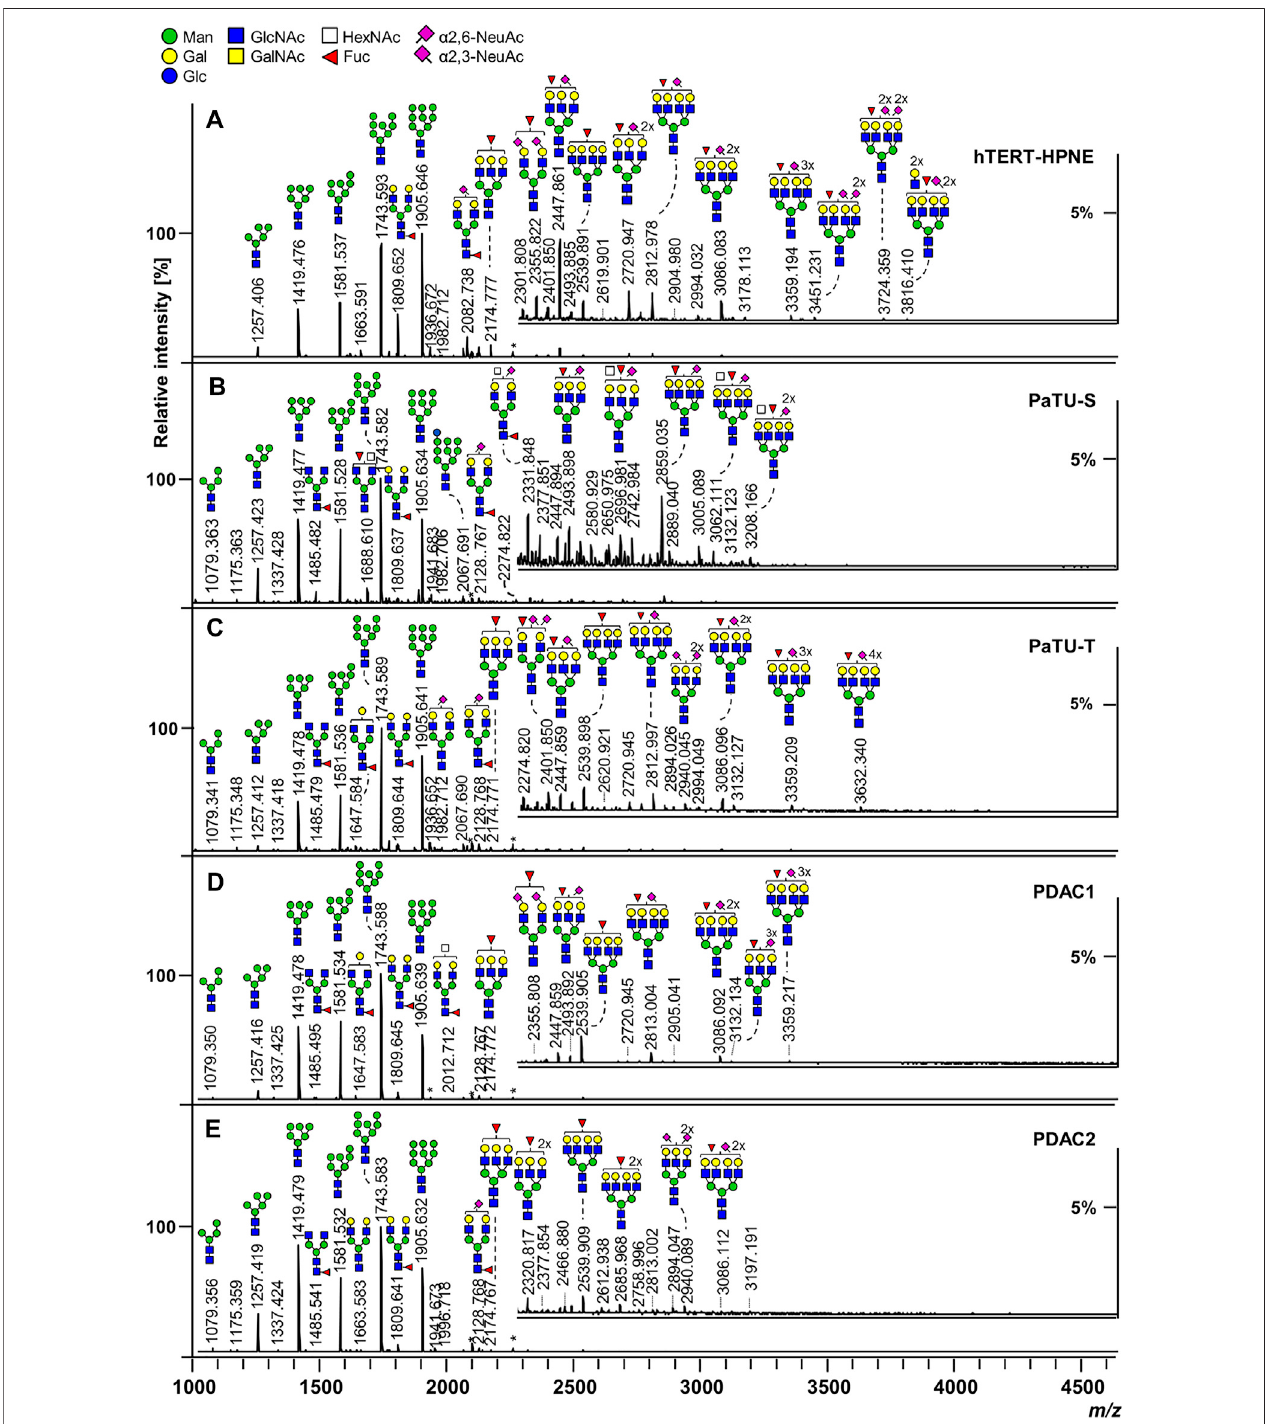
FIGURE3| MALDI-TOF-MSspectraofreleasedandderivatizedN-glycansfrompancreaticduct (A) andcancercells (B – E) .Reproduced fromHolst,S.,Belo,A.I., Giovannetti, E., Van Die, I., and Wuhrer, M. (2017). Pro fi ling of different pancreatic cancer cells used as models for metastatic behaviour shows large variation in their N- glycosylation. Sci. Rep. 7, 16623. doi: 10.1038/s41598-017-16811-6 under a Creative Commons Attribution 4.0 International License (http://creativecommons.org/ licenses/by/4.0/).